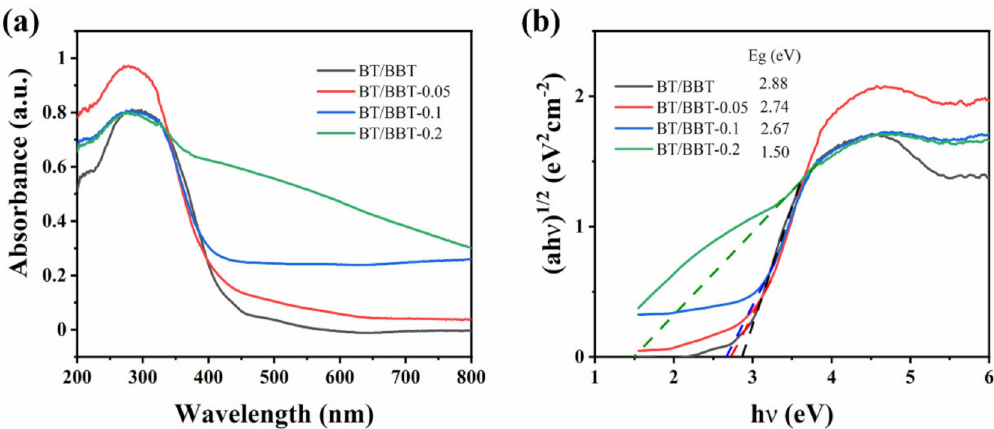
Figure 4. ( a ) UV–Vis absorption spectra of the sample photocatalysts, ( b ) plots of ( α h ν ) 1/2 versus h ν of the sample